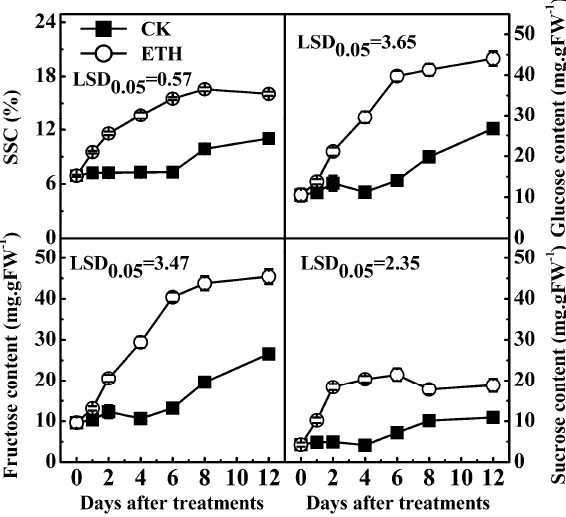
Figure 3. Effect of ethylene treatment (ETH, 100 µL/L, 24 h) on soluble solids content (SSC) and soluble sugars in “Hayward” kiwifruit at 20 °C. Error bars represent ±SE from three replicates. FW, fresh weight. LSDs represent least significant difference at p = 0.05.